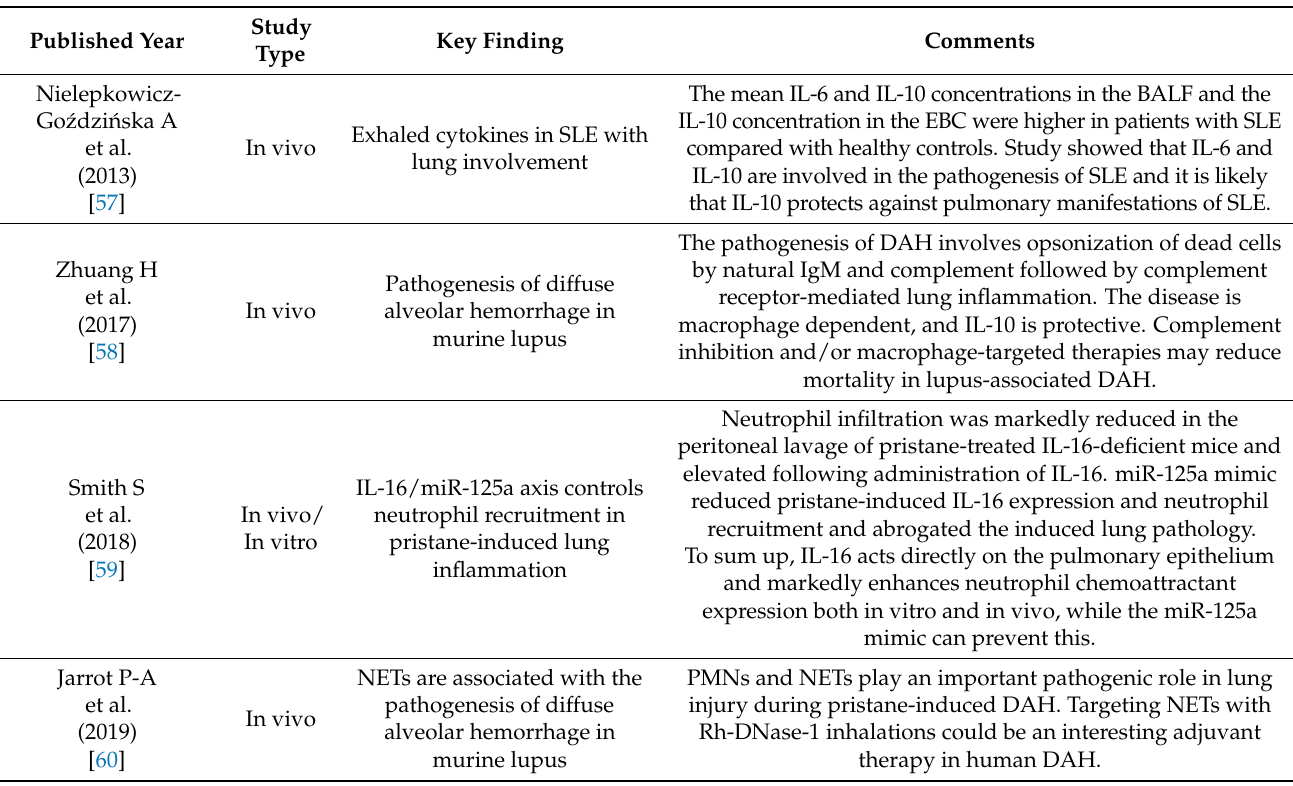
Table 1. Studies on the pathogenesis of lupus-associated lung